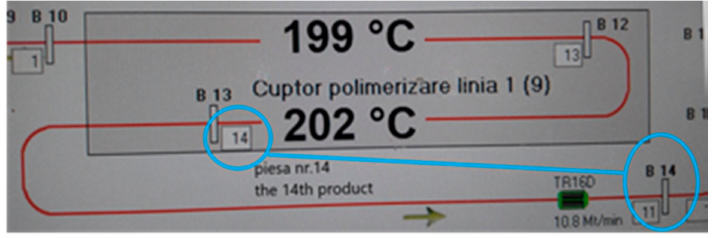
Figure 3. The polymerization process after implementation.